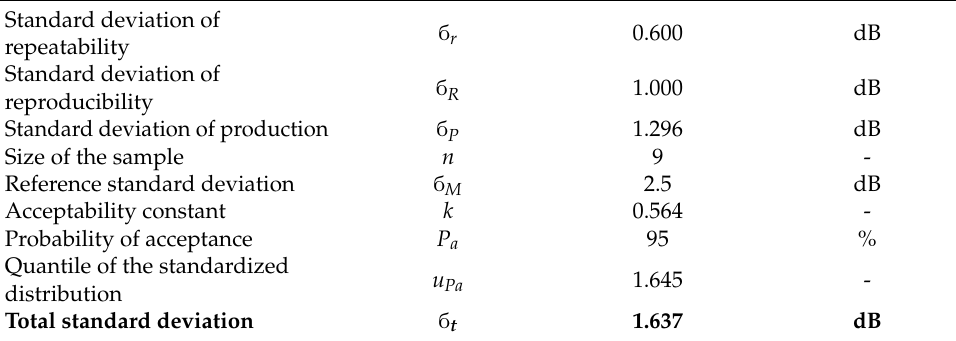
Table 2. Calculation of total standard deviation of the sound measurements.